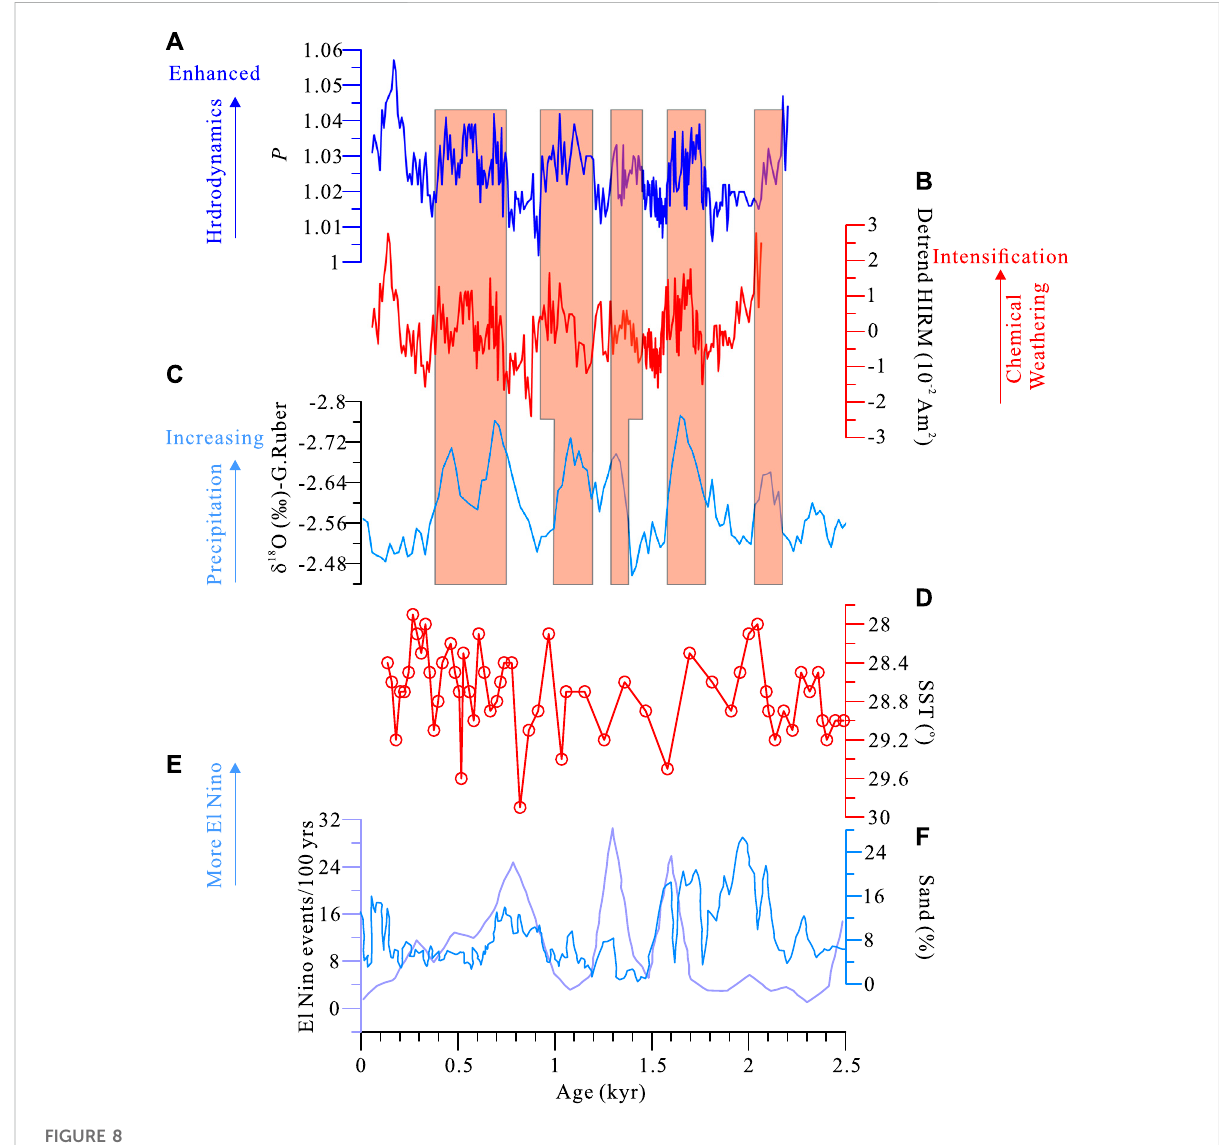
FIGURE 8 Comparison of p (A) ,HIRM (B) with δ 18 Oofcore 17,940 (C) (Wang etal.,1999),thesea surfacetemperature (SST)ofthewestern Paci fi c (E) (Stott et al., 2004) and ENSO proxies (F,G) (Moy et al., 2002; Conroy et al.,